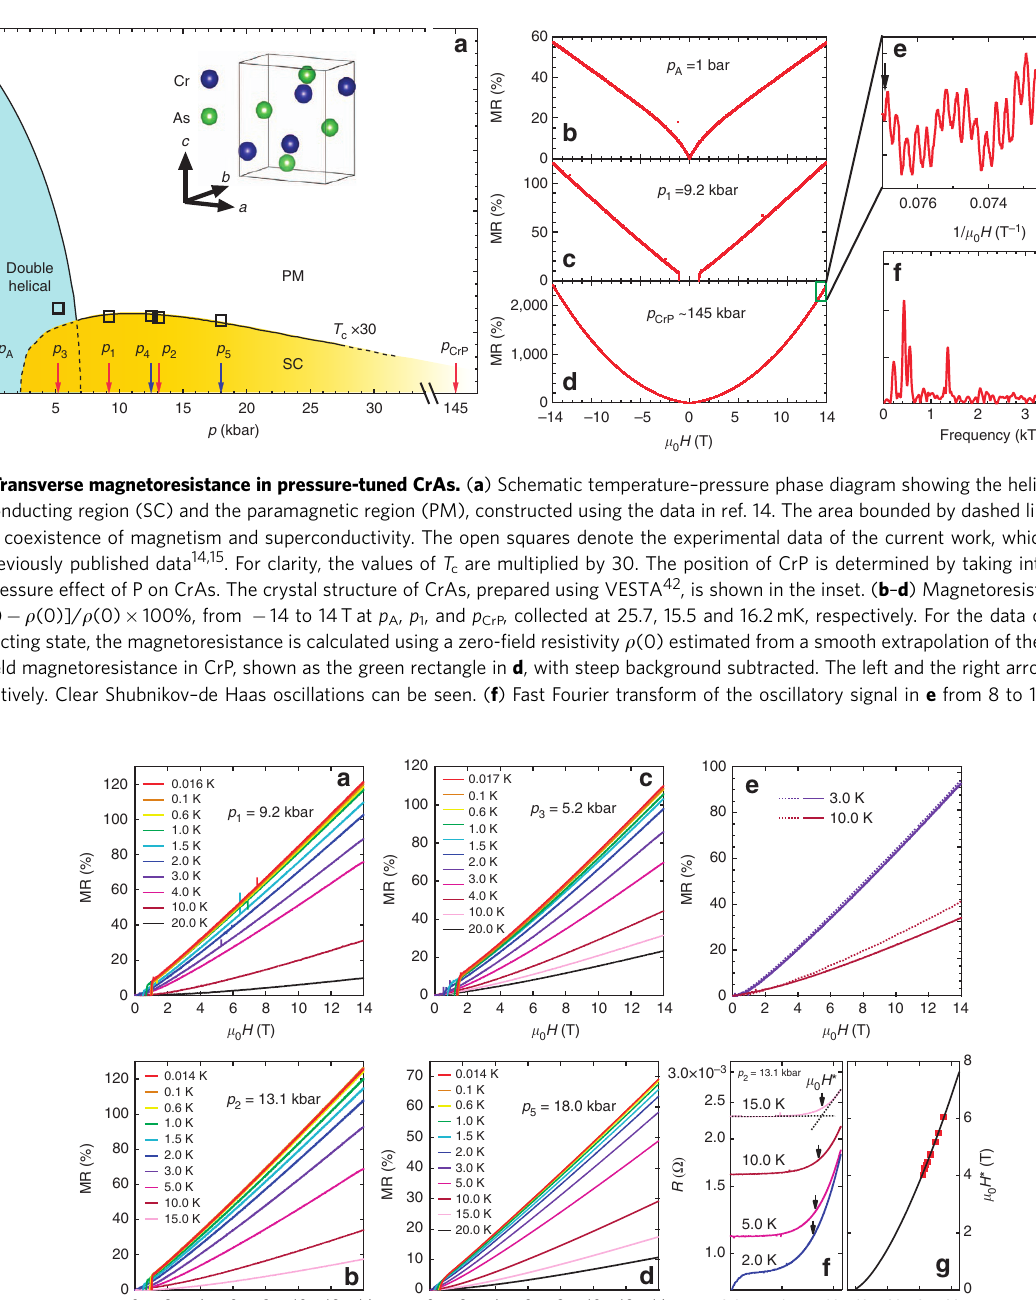
the experimental lattice parameters 24 . At the Y point, a band crossing is found at B 8.6 meV below E F along the k y direction, giving rise to a linear energy–momentum dispersion with a slope : c . Along the Y – S direction, which is parallel to G – X (Fig. 3c), the dispersion is quadratic, parametrized by m . The crossing point at Y is thus analogous to the semi-Dirac point discussed in the literature 26,27 , except that the parabolic branches are degenerate in our case. Such a hybrid dispersion relation is a result of the NATURE COMMUNICATIONS|8:15358|DOI: